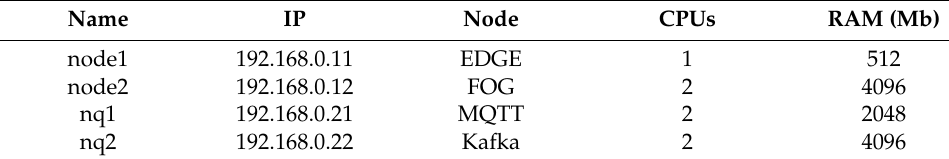
Table 3. Vagrant machines’ configuration for simulating the necessary